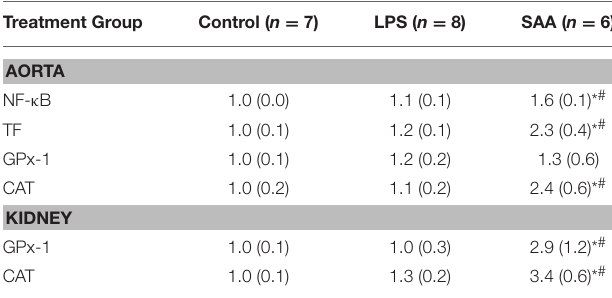
TABLE 1 | Gene expression in aortic and renal